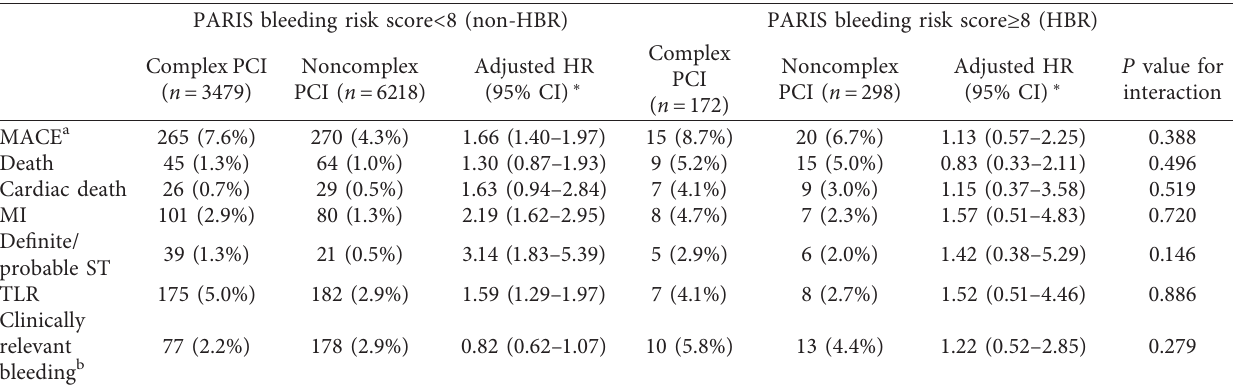
Table 3: HRs for adverse events associated with complex PCI stratified by PARIS bleeding risk